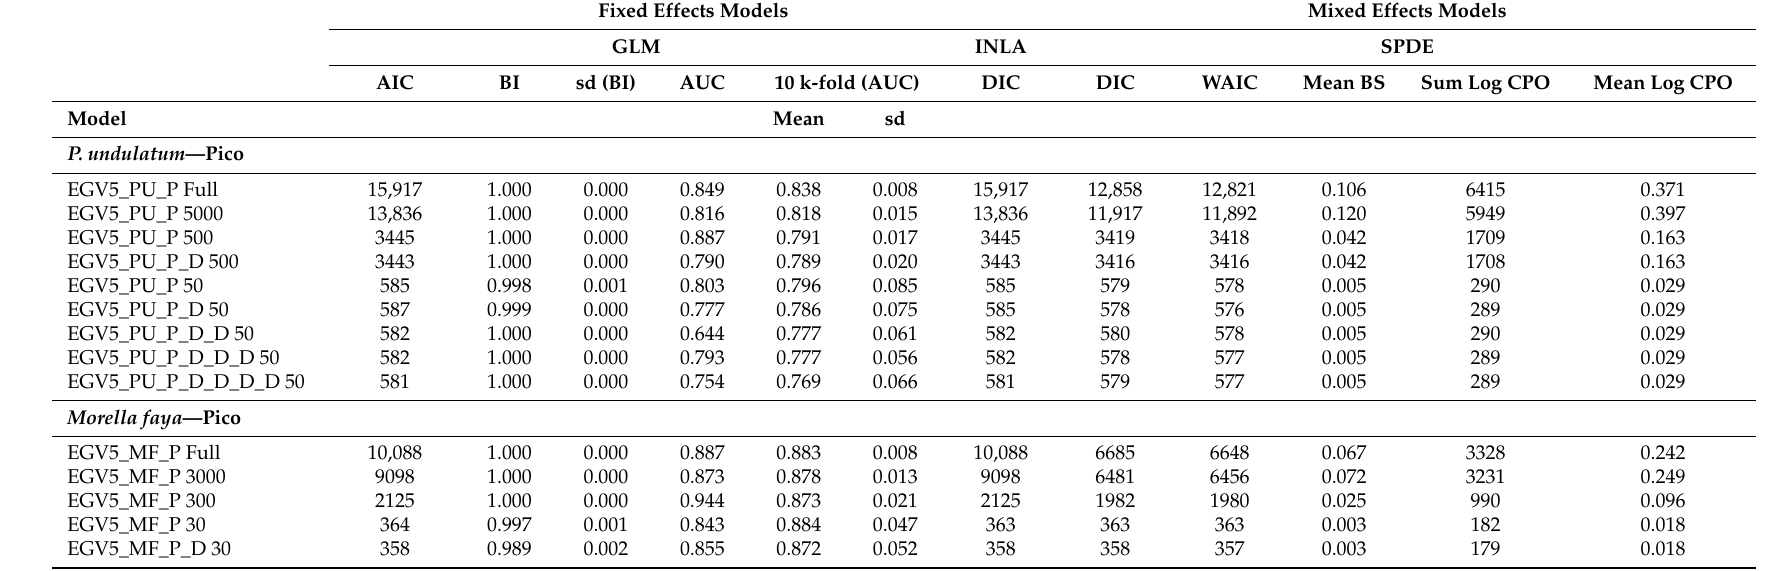
Table 5. Results of sampling reduction on fixed and mixed effects models regarding EGV set 5 for P. undulatum and M. faya in Pico Island. BI: Boyce Index; sd: standard deviation; BS: Brier Score; PU: P. undulatum ; MF: M. faya ; P: Pico. Variables with non-significant values were excluded from the model (code: D) (Supplementary